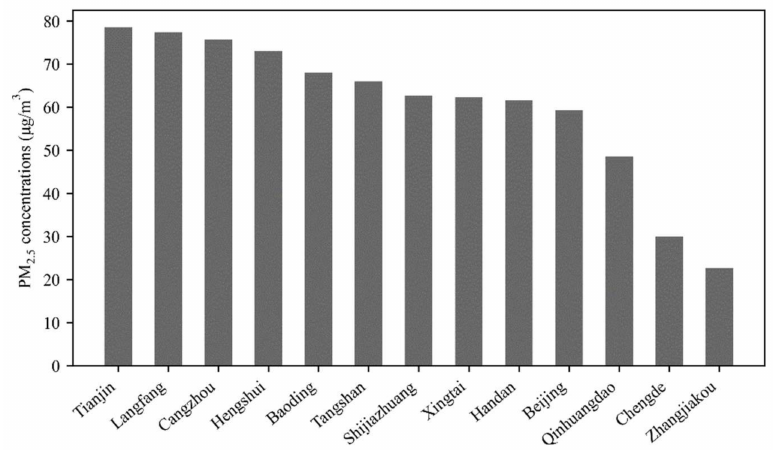
Figure 2. Annual average PM 2.5 concentration of cities in the Beijing–Tianjin–Hebei urban agglomer- ation in